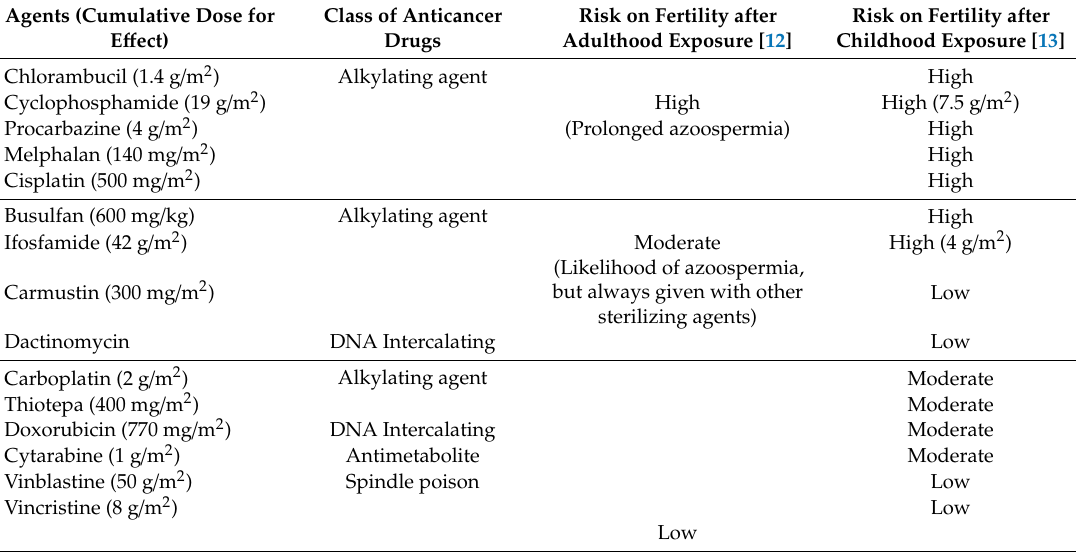
Table 1. Risks of the main anticancer drugs on men fertility diagnosed in adulthood or in childhood. Agents (Cumulative Dose for E ff